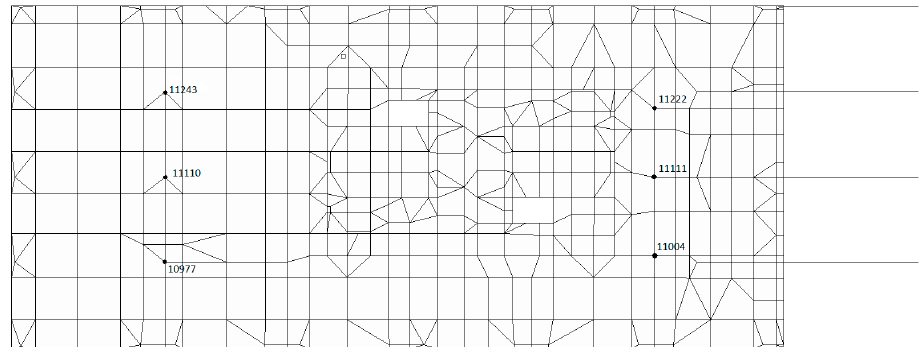
Figure 20. FEM model of the last floor ceiling with the numbers of nodes in which the TMDs’ location was assumed.